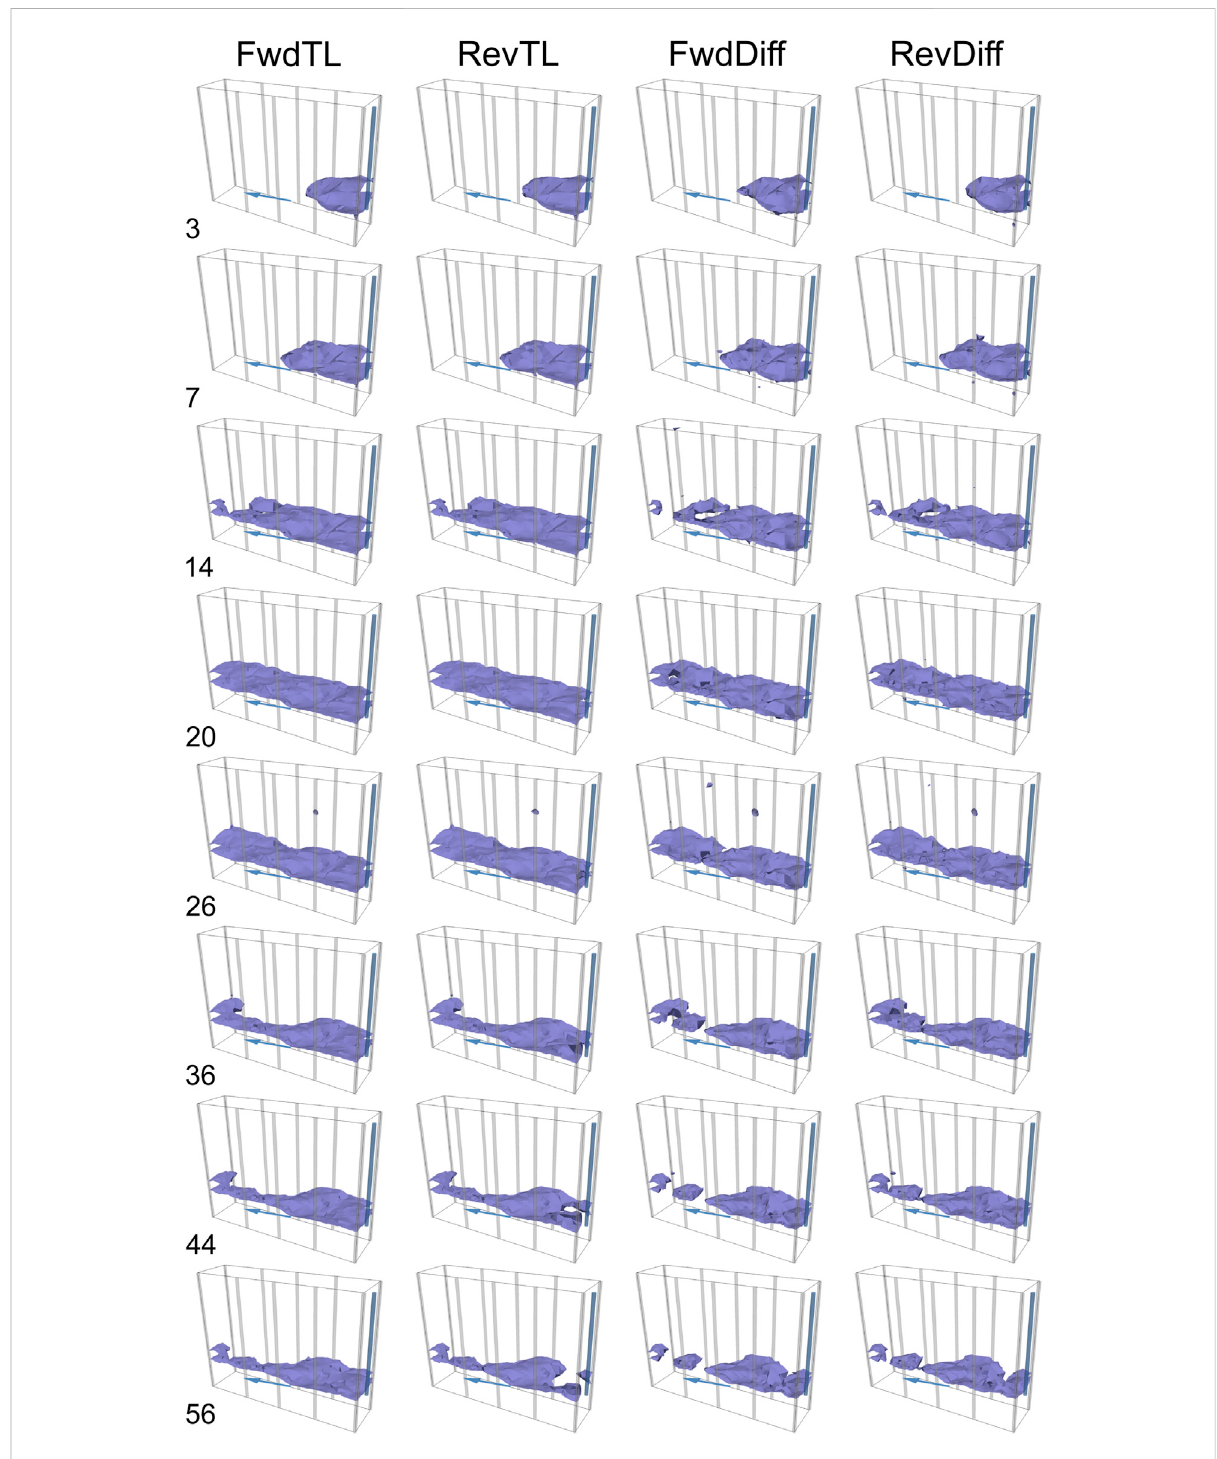
FIGURE 4 Distributions of fractional resistivity change at the former gasworks site for the forward and reverse time-lapse and difference inversions at the timesteps indicated on the left-hand side. Isosurfaces indicate resistivity changes of − 20%. Blue arrows show groundwater fl ow